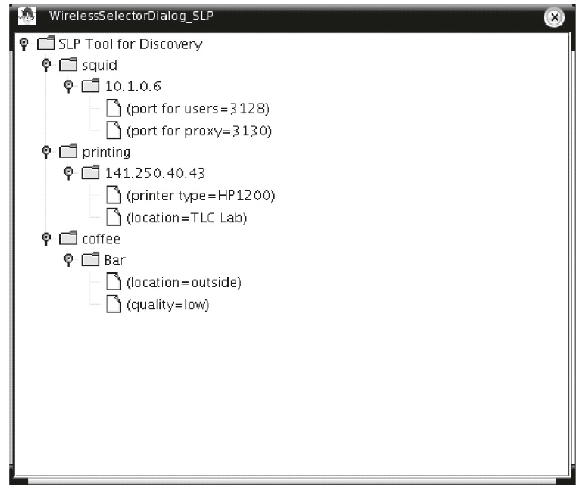
Figure 4: TWS: service information from SLP.